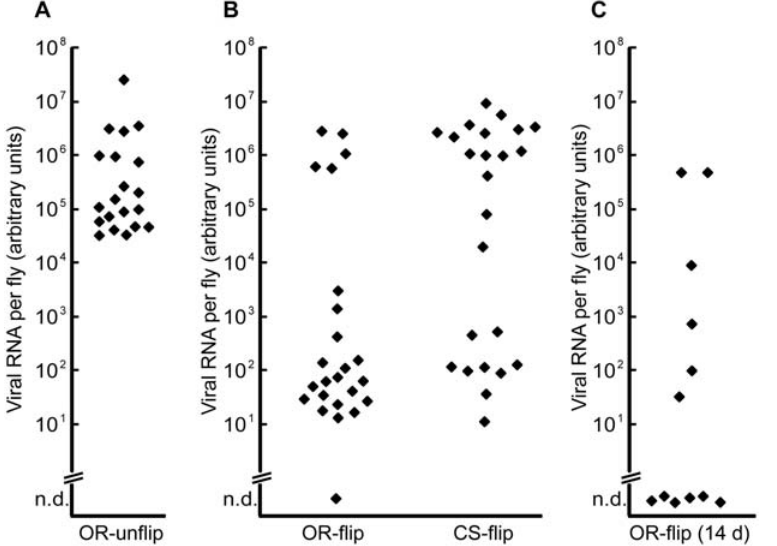
Figure 1. Nora virus clearance. Viral RNA in single flies kept (A) four days on contaminated food (unflip), or serially transferred for (B) four and (C) fourteen days to clean food (flip). Every dot represents the quantification from a single fly. OR: Oregon R, CS. Canton S, n.d: not detected.